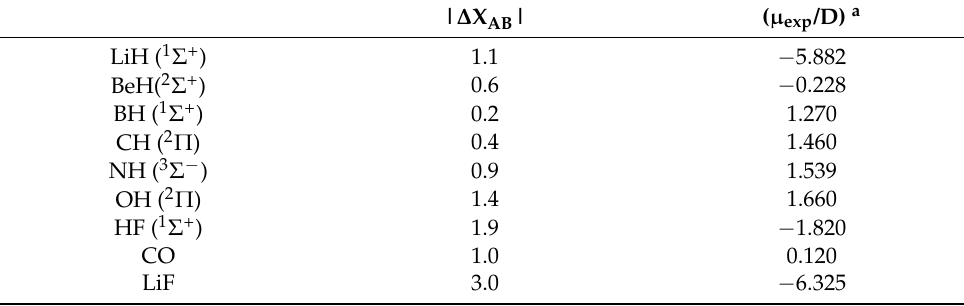
Table 1. Experimental dipole moments. A positive dipole moment indicates A + B − polarity.